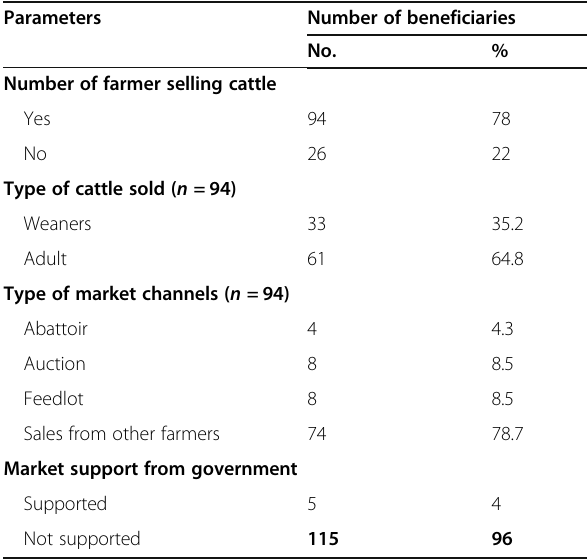
Table 5 Cattle selling by the beneficiaries of the Nguni Cattle Project in Eastern Cape (No. =